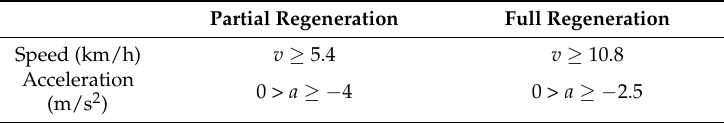
Table 7. Regenerative braking speed and acceleration limits.